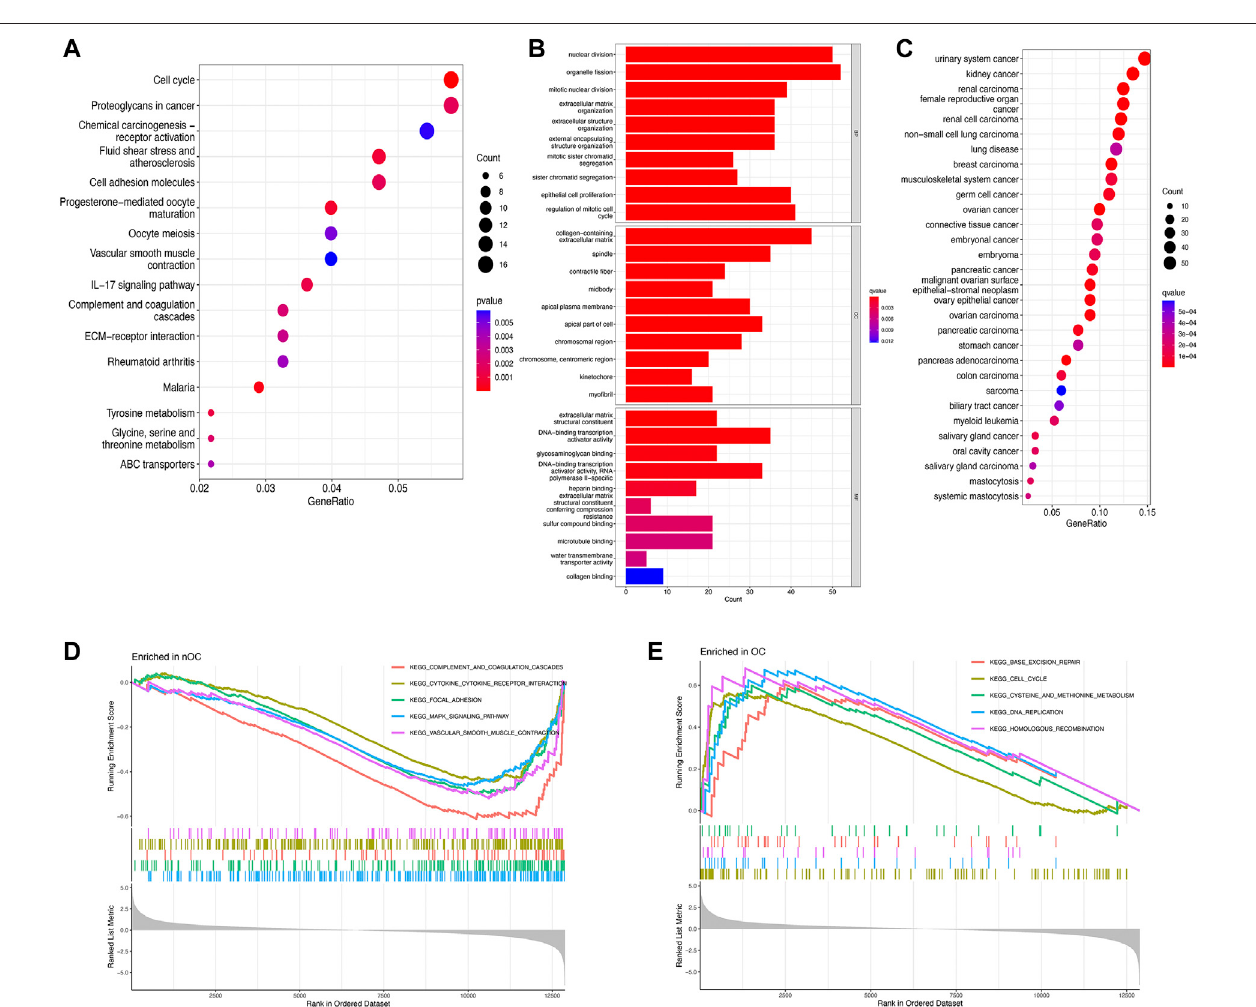
FIGURE 3 | Enrichment analysis of differentially expressed genes. KEGG pathway analysis (A) , GO function analysis (B) , Disease analysis (C) , and GSEA analysis (D,E) show the active functions or pathways in the OC and nOC groups, respectively.